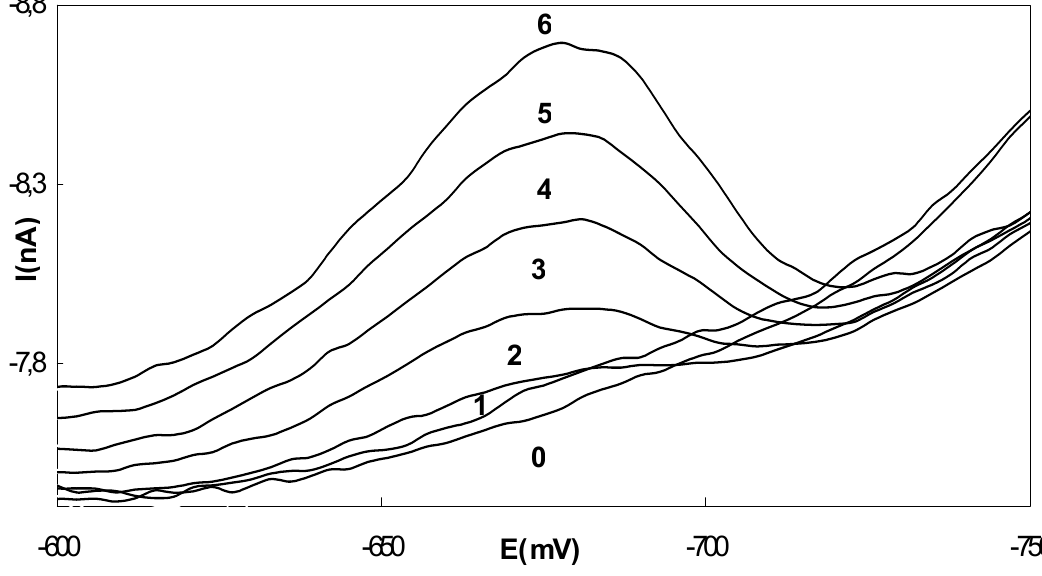
Figure 8. Differential pulse voltammograms of Ostazine Orange at m-AgSAE in 0.01 mol L -1 NaOH. c (Ostazine Orange) [µmol L -1 ]: (0) 0 (base electrolyte), (1) 0.2, (2) 0.4, (3) 0.6, (5) 0.8, (6)1.0. Potentials for regeneration E = -350 mV, E = -1600 in fin